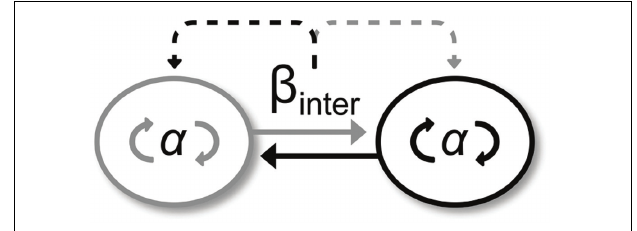
FIGURE 6 | A simple model capturing the difference in coupling strength between intra- and inter-personal levels, leading to the transfer from the stronger to the weaker. The two circles represent the two participants interacting together (full line arrows) during an intentional interpersonal coordination task (strong coupling β inter ) while maintaining their own postural coordination (weak coupling α ). The coupling difference yields to a transfer from the stronger to the weaker type of coupling (dotted line arrows), leading to improvement in intrapersonal postural